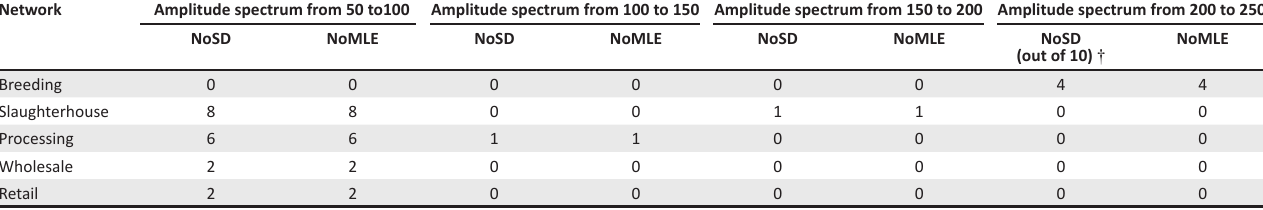
TABLE 7: Results of the post hoc test, data sets sorted by variable amplitude. Network